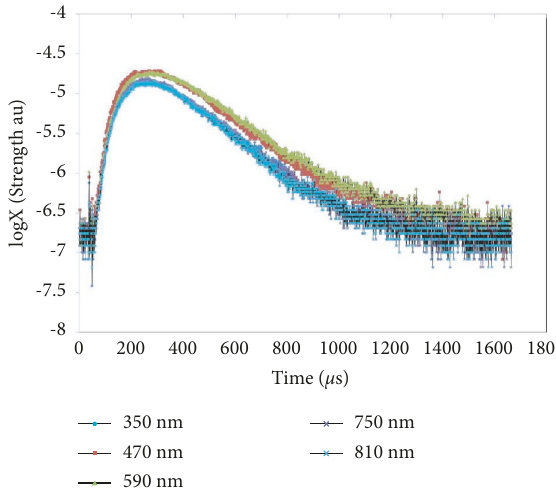
Figure 6: Measured fluorescence decay.